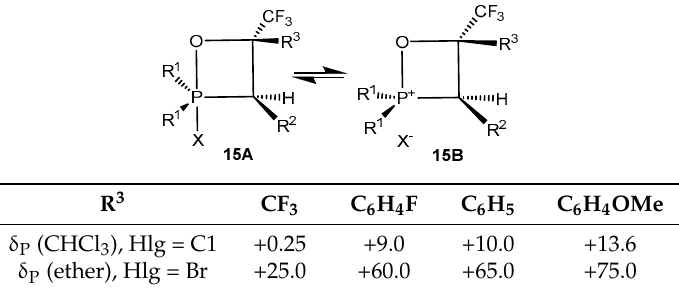
Table 4. Effect of solvent on δ P of 2-chloro and 2-bromo-1,2 λ 5 -oxaphosphetanes.